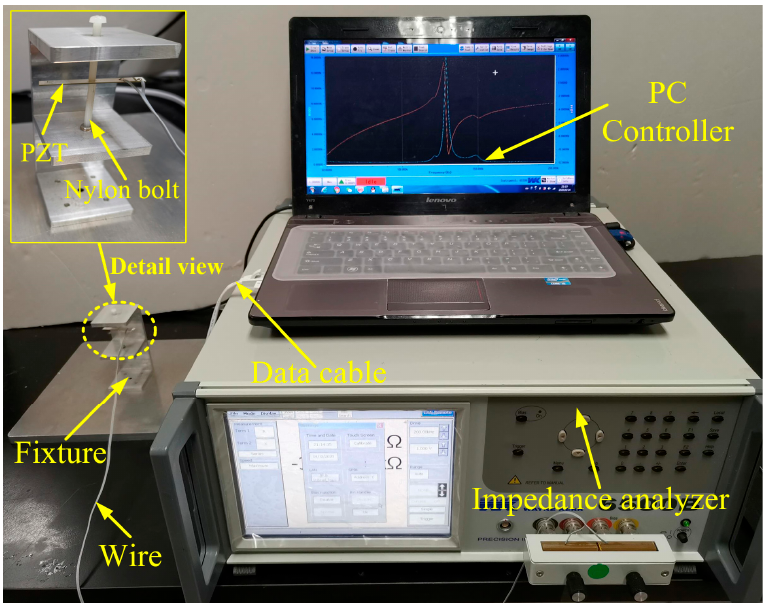
Figure 4. The testing platform of PZT in a free state.